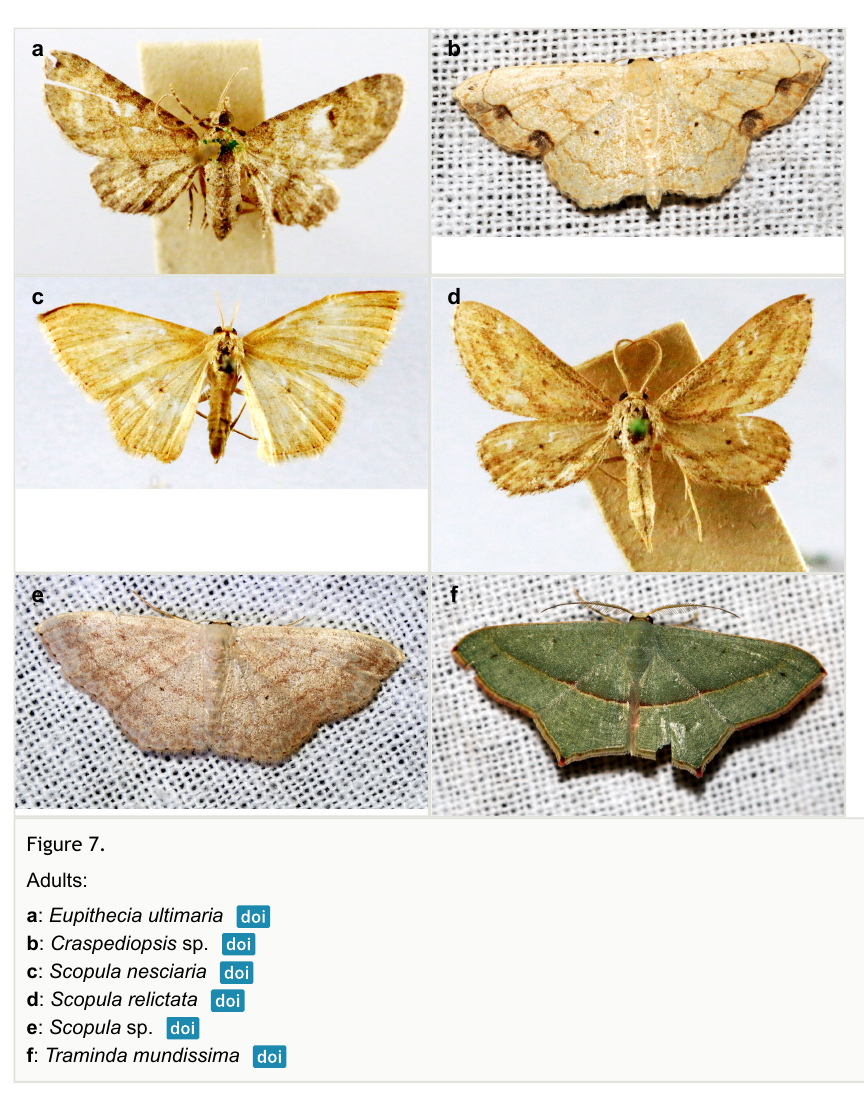
Pasiphila rectangulata (Linnaeus,